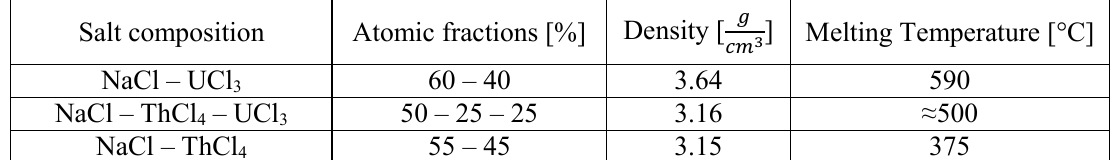
Table I. Fuel salt compositions: Fuel salts included in the B&B feasibility study